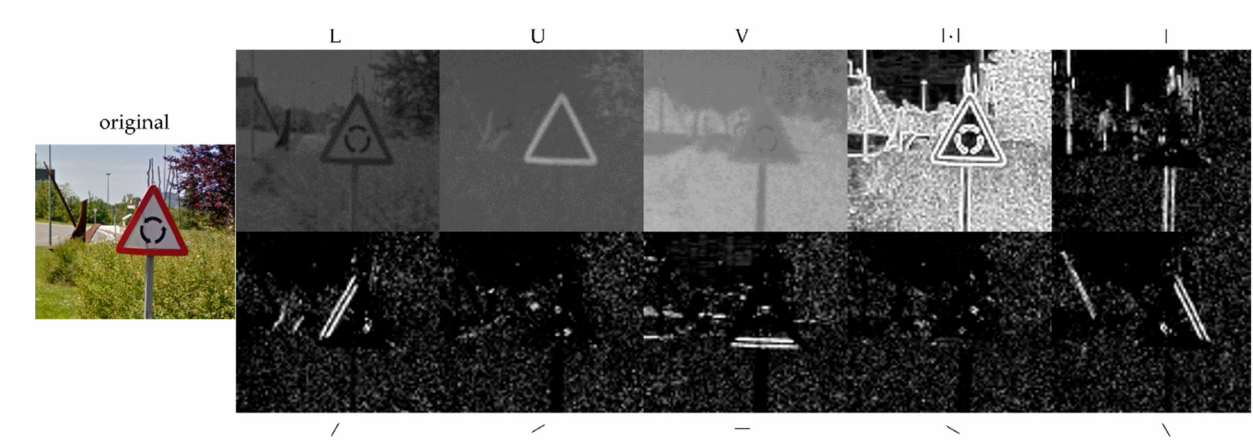
Figure 4. The Aggregated Channel Features (ACF). In the first row, from left to right: the original image, LUV channels, the gradient magnitude and individual representation of the HOG features at different angles of the sample